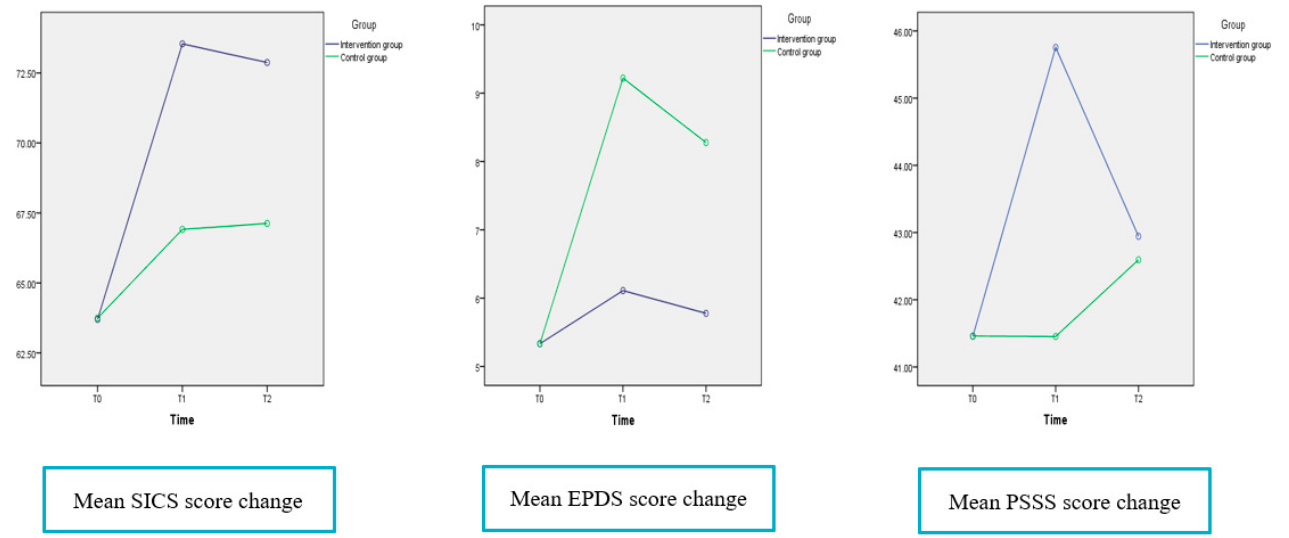
Figure 2. The mean score change in parenting outcomes of MSE, postpartum depression and social support. SICS: the Self-efficacy in Infant Care Scale; EPDS: the Edinburgh Postnatal Depression Scale; PSSS: the Postpartum Social Support Scale.